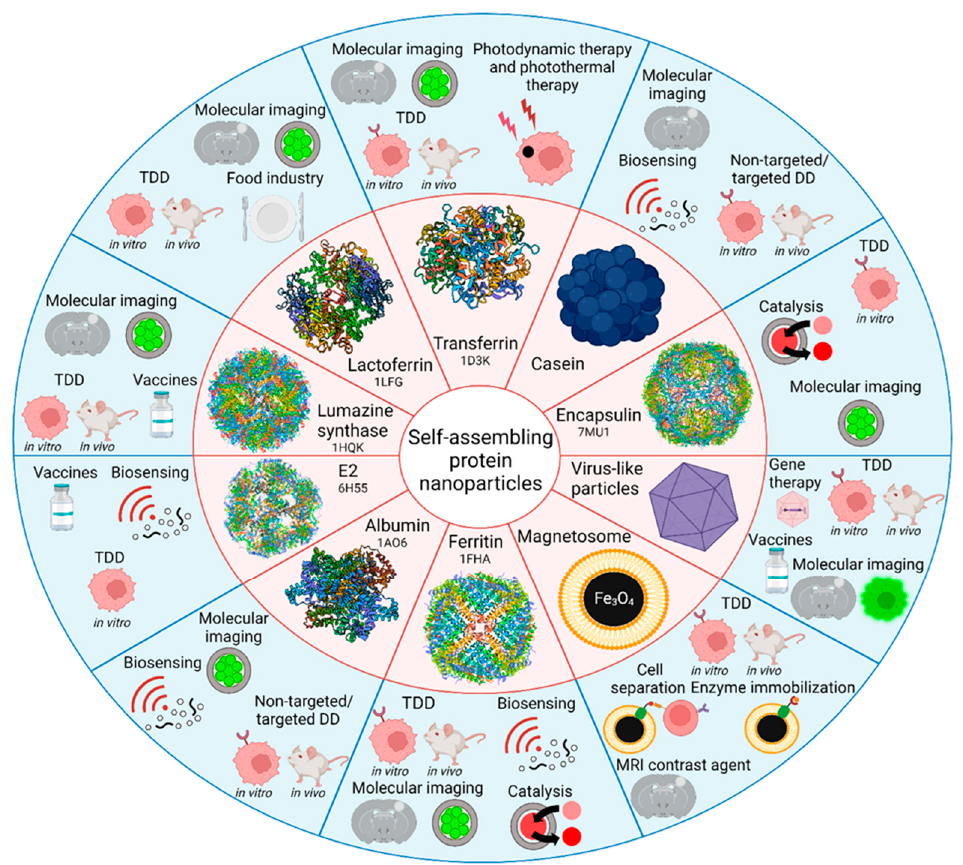
Figure 1. The diversity of self-assembling protein nanoparticles and their applications for in vitro and in vivo research, including biosensing, molecular imaging, and photodynamic or photothermal therapies. The structure of protein nanoparticles is accompanied by the Protein Data Bank (PDB) number if applicable.